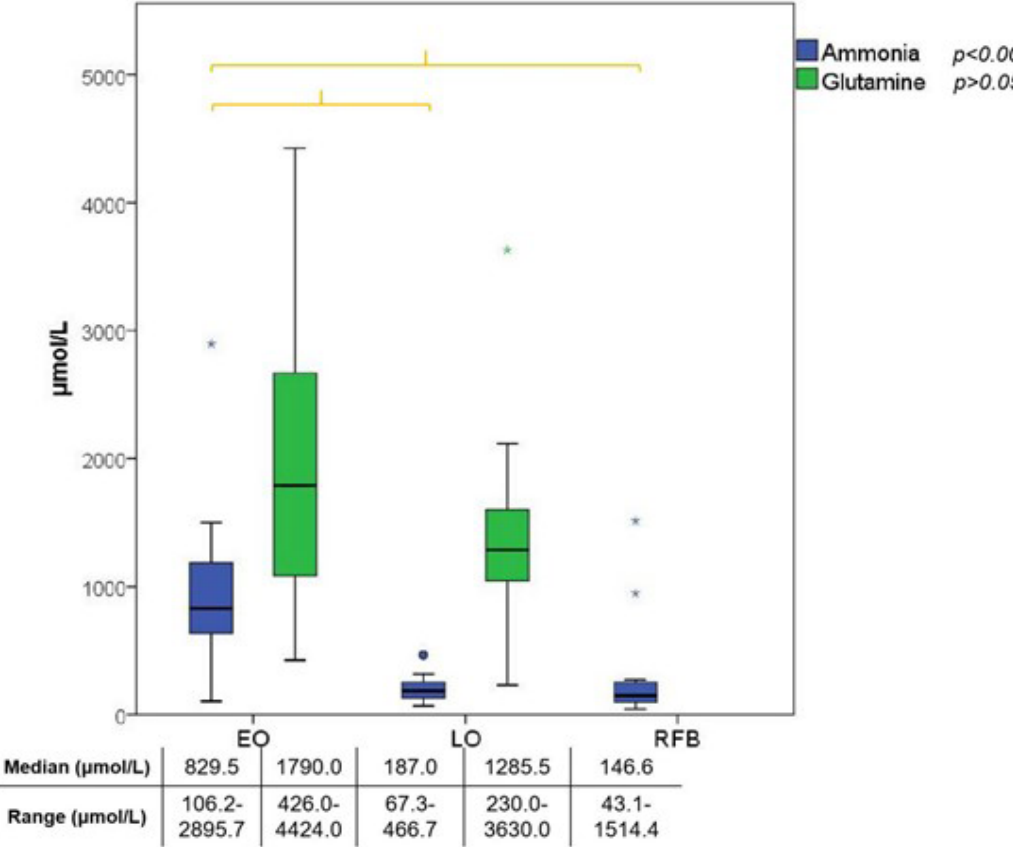
Figure 3. Ammonium and glutamine values according to the presentation of the disease. The distribution of the ammonium values are shown in box plots for the EO, LO and FRB patients, and the distribution of the glutamine values for the EO and LO patients. The braces indicate between which groups significant differences were detected in the post hoc